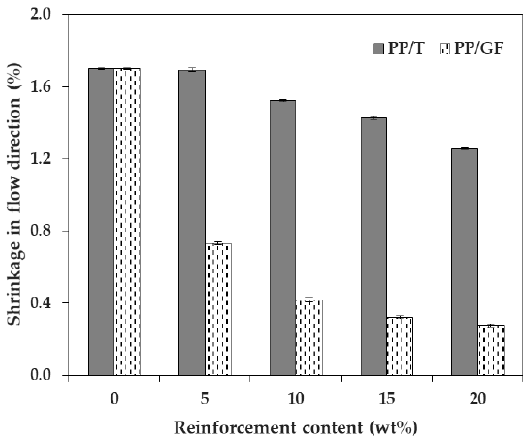
Figure 2. Shrinkage of talc-reinforced polypropylene composites (PP/T) and glass-fiber-reinforced polypropylene composites (PP/GF) in the flow direction, depending on the reinforcement type.